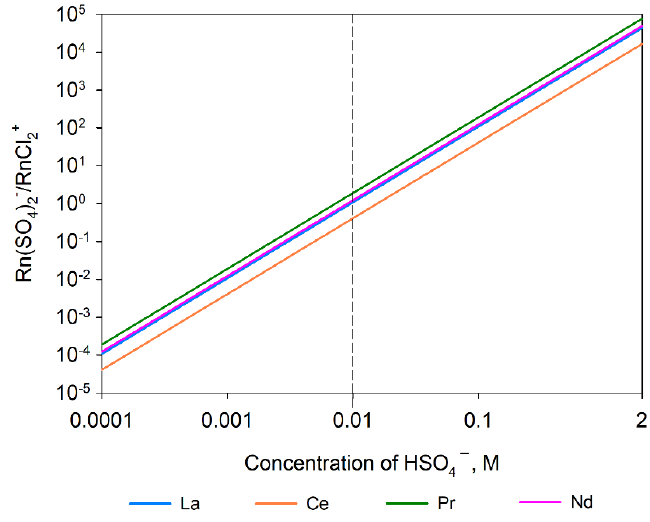
Figure 3. The ratio of Rn(SO 4 ) 2 − to RnCl 2+ as a function of HSO 4 − concentration at pH 1.